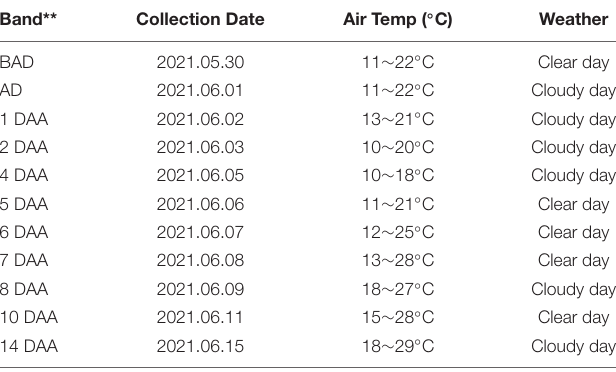
TABLE 2 | Weather conditions during data